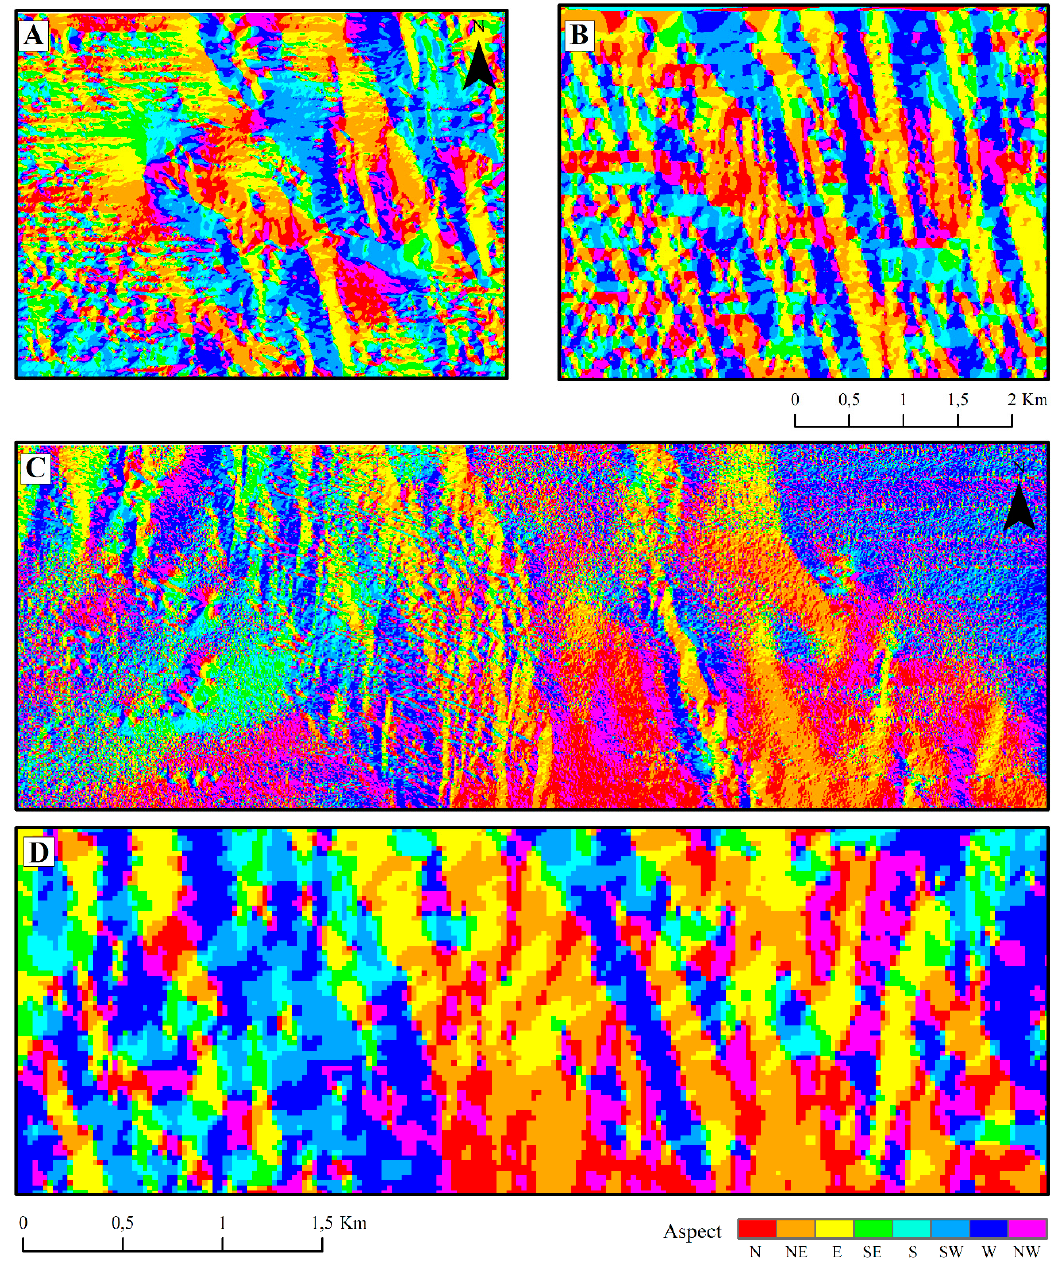
Figure 6. Aspect of slopes based on the MBES DBMs; ( A ) multibeam relief for the Vyborg key area, ( B ) glacial moraine surface of the Vyborg key area, ( C ) multibeam relief of the Moschny Island key area, ( D ) glacial moraine surface of the Moschny Island key area.